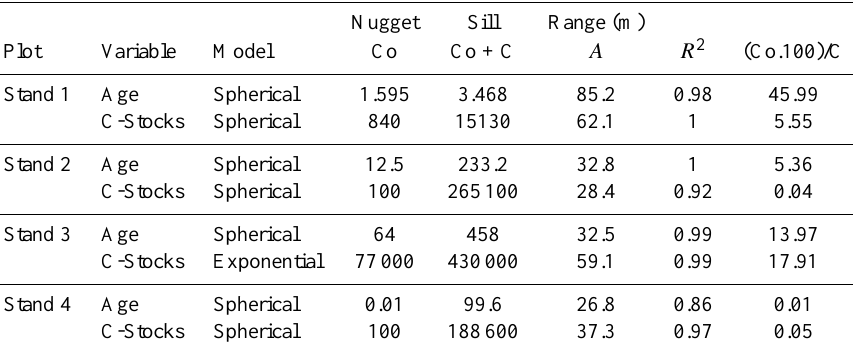
Fig. 6. (A) Age structure of the studied stands. Kriged maps indicate the spatial distribution of (B) tree age and (C) carbon stocks of the studied stands. Table 5. Results of the variogram analysis: Co is the nugget effect, Co+C is the sill representing the variance, A is range of spatial dependence, and (Co.100)/C is the proportion of variance explained by random